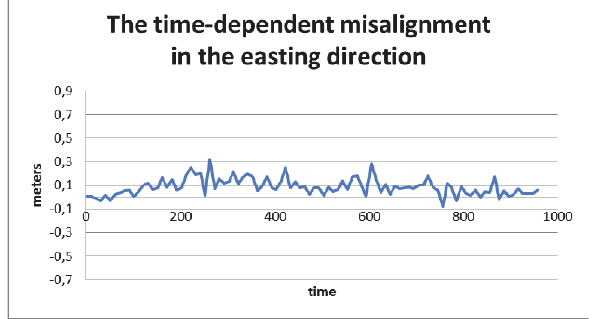
Figure 11. The misalignment of the BLS patch centre points in the easting direction after the time-based correction.